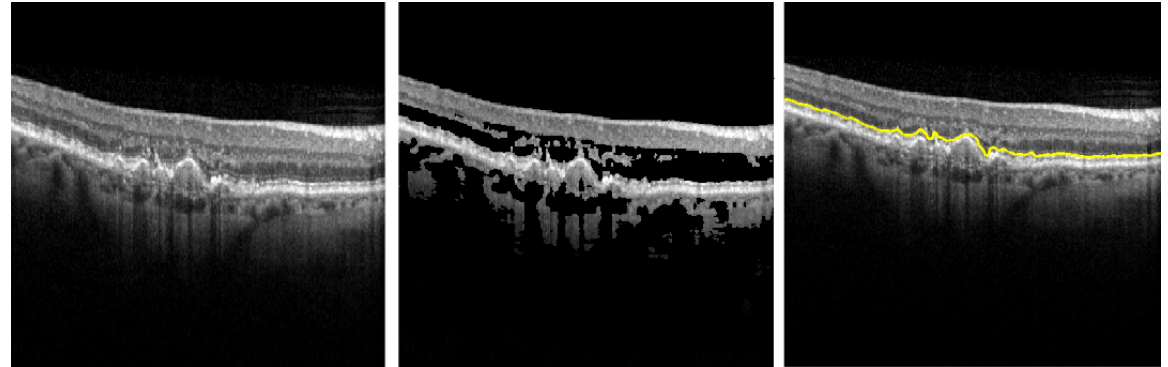
Figure 2. Modifying the initial OCT image ( left ) with an adaptive thresholding algorithm based on Equation (1) ( center ) aiming to accurately detect the easiest frontier between the IS and OS layers ( right ).